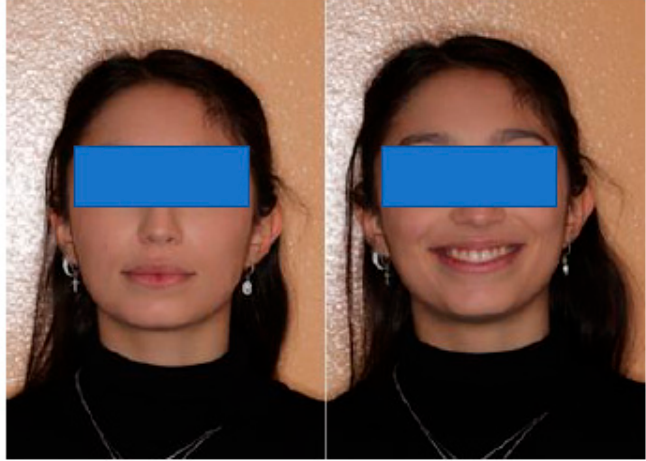
Figure 15. Extra-oral facial